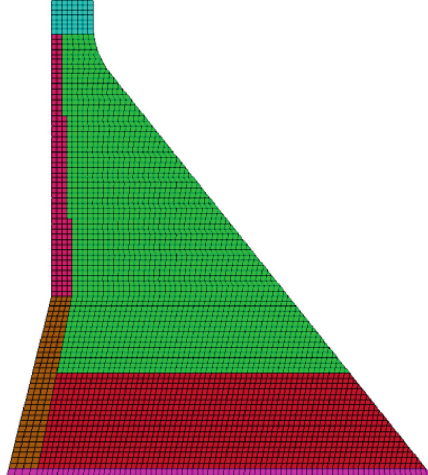
Figure 2: Finite element model of the dam.